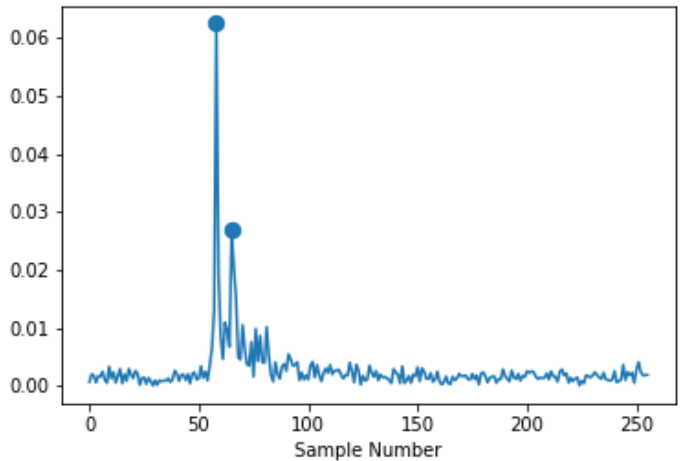
Figure 1. An example of feature extraction from the KWAUG14 channel impulse response. Significant arrivals have a